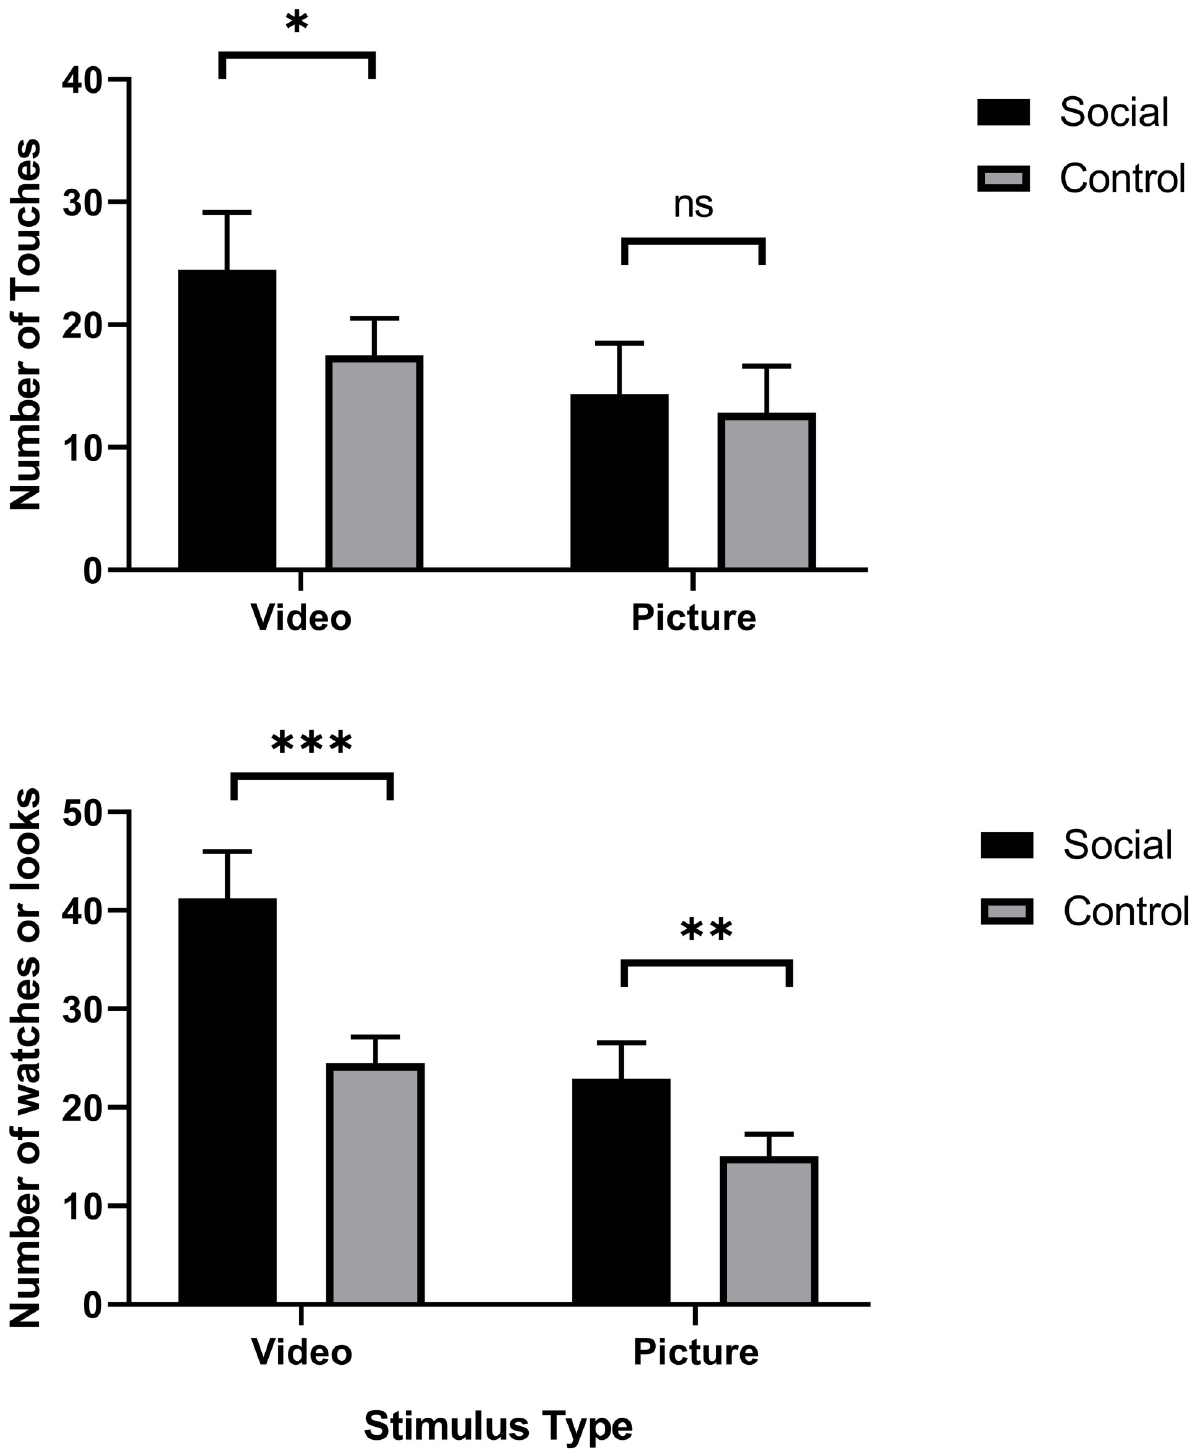
Fig 2. The cumulative number of times the chimpanzees (a) touched to initiate playback of social and control videos and (b) the number of times they watched social and control videos. Bars represent the average across subjects, error bars indicate std. error. ��� p < 0.001; �� p < 0.01; � p < 0.05.